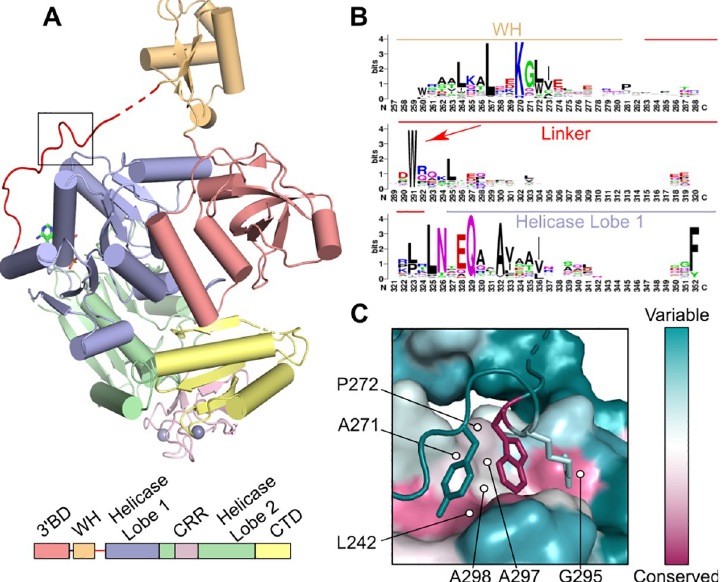
Fig 1. PriA sequence alignment identifies a conserved interaction within PriA. (A) Structure of K . pneumoniae PriA [6, PDB:4NL4] with schematic domain layout. Linker of interest shown in red. Box highlights the linker/HD interface. (B) Logo from an alignment of 300 PriA molecules. Parts of the WH and HD are shown along with the linker. Red arrow indicates position of E . coli Trp186. Note: Sequence alignment numbers do not align with E . coli numbering due to variations in the lengths of non-conserved regions of PriA proteins from other bacteria. (C) Structure of the HD pocket colored by conservation score [20]. Trp186, Arg187, and Tyr190 are shown as sticks and HD pocket residues are labeled. Conservation score color scale is